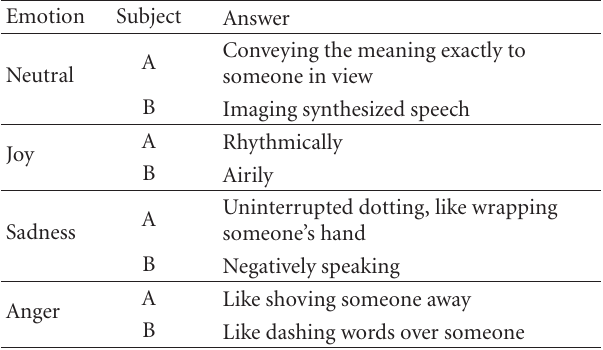
Table 2: Standardized coe ffi cients of canonical discriminant func- tions and contribution ratios (two-handed Finger Braille).